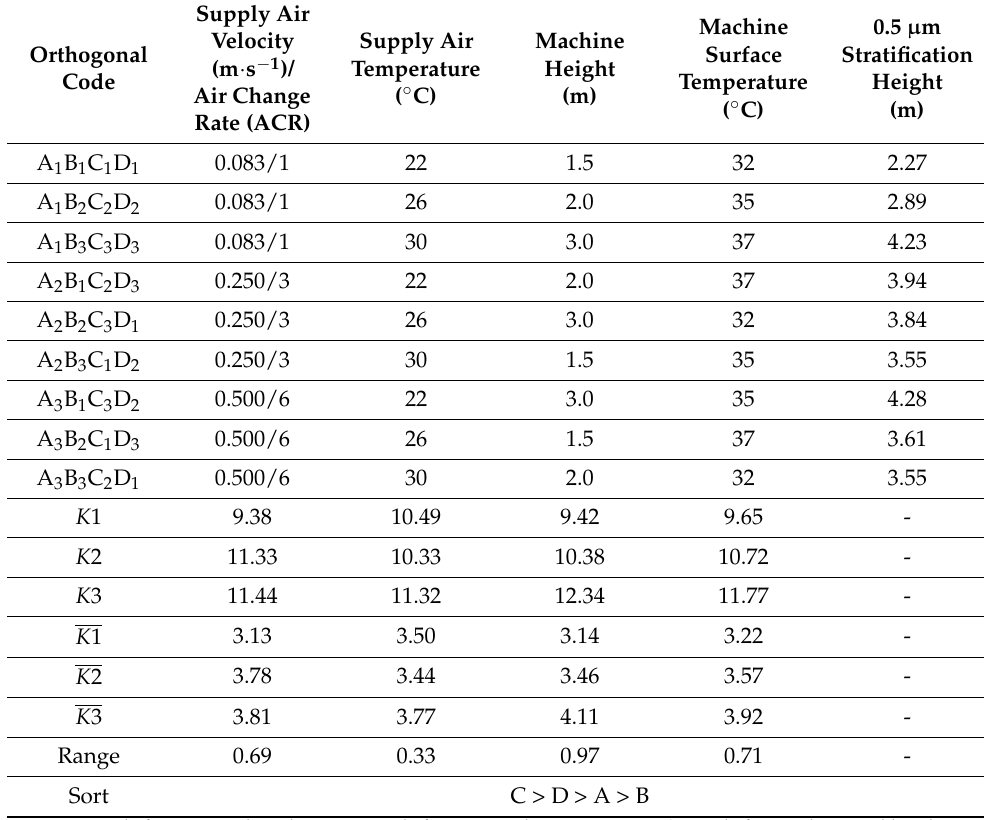
Table 6. Process of 0.5 µ m stratification height range analysis in the orthogonal experiment.